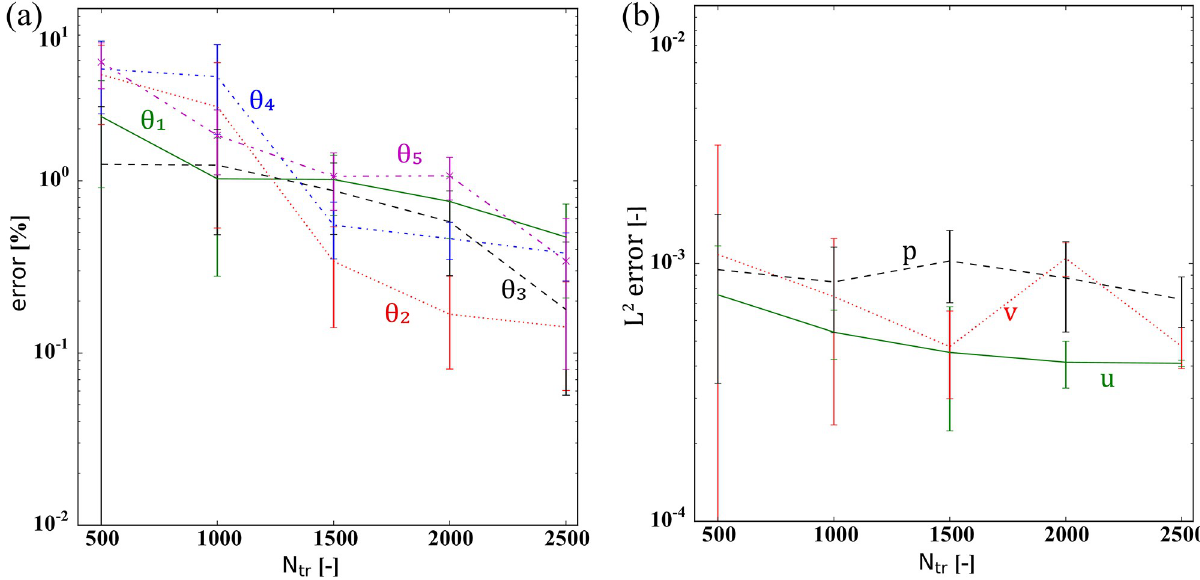
Fig 10. Biot’s equations—inverse modeling: PINN performance as function of training set size. This figure shows the estimated error dependency on the amount of training data, N tr . (a) θ 1 , θ 2 , θ 3 , θ 4 , and θ 5 and (b) u , v , and p . The error bars show mean and standard derivation ( ± 1 SD) based on 27 realizations. The reported error values of θ 1 , θ 2 , θ 3 , θ 4 , and θ 5 are percentage errors while the relative L 2 error is shown for u , v , and p . Note that there is no noise in this investigation.